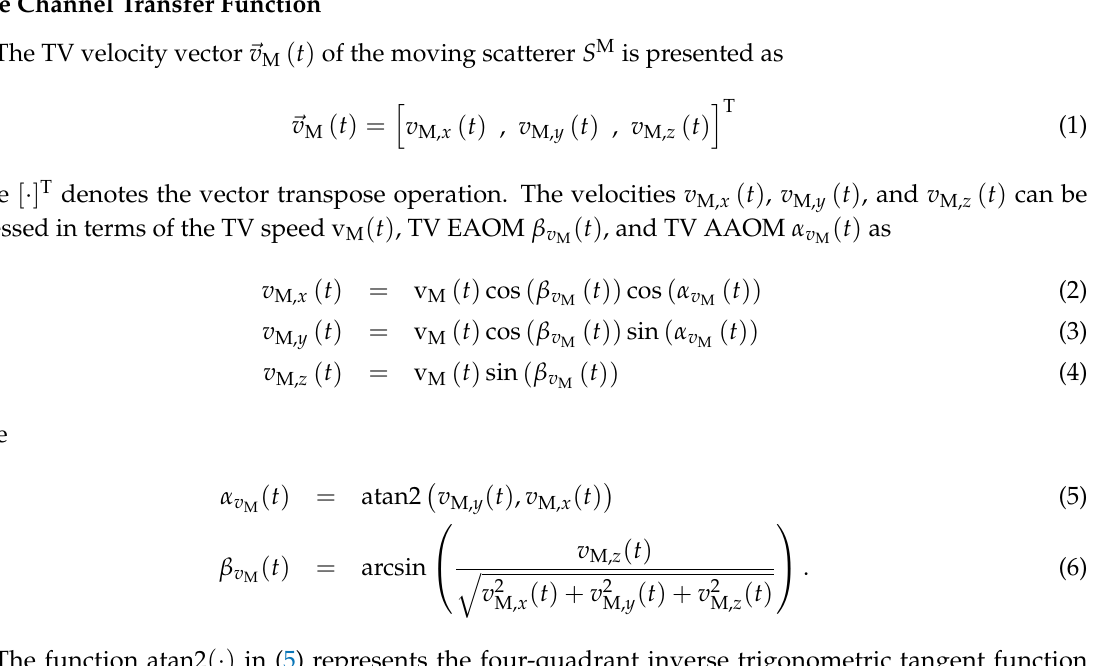
Figure 1. Geometrical model of a 3D multipath propagation scenario with one moving scatterer S M and M fixed scatterers S F m , m = 1, 2, . . . , M